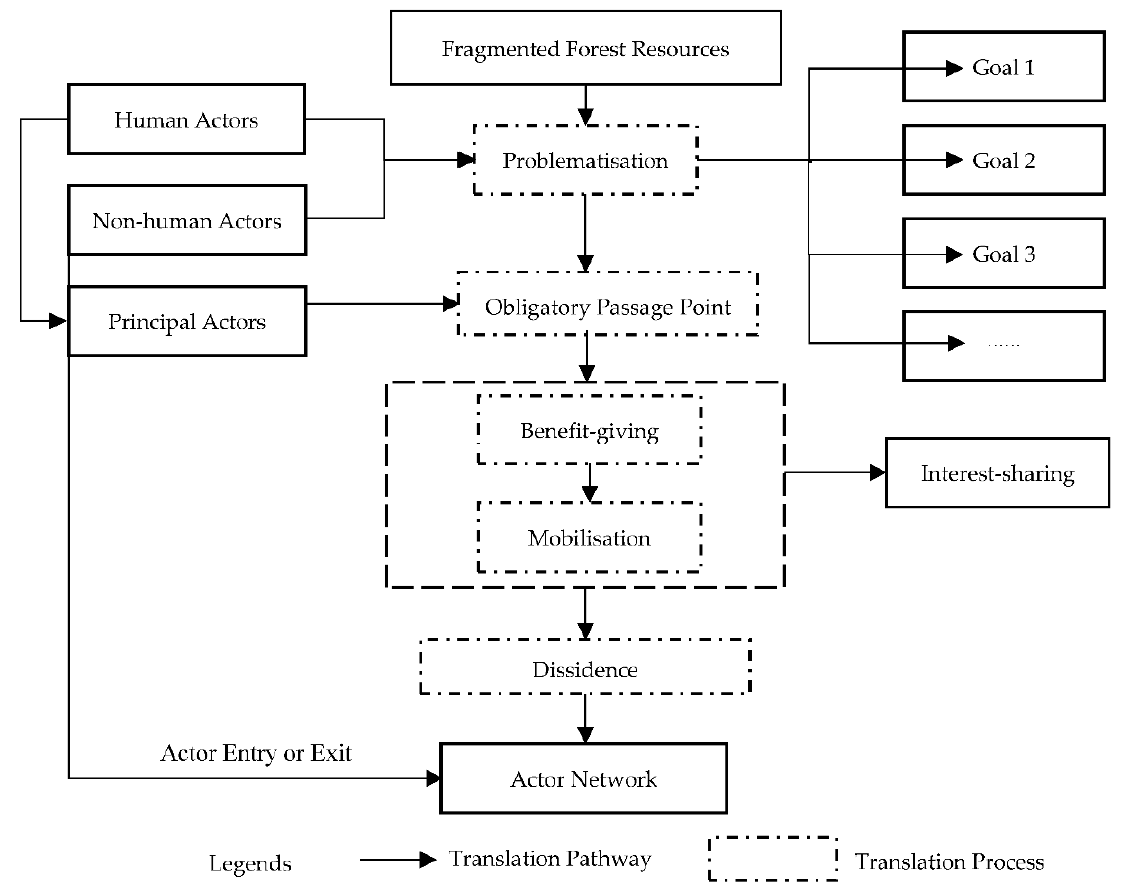
Figure 1. Research framework of the FEB actor network.